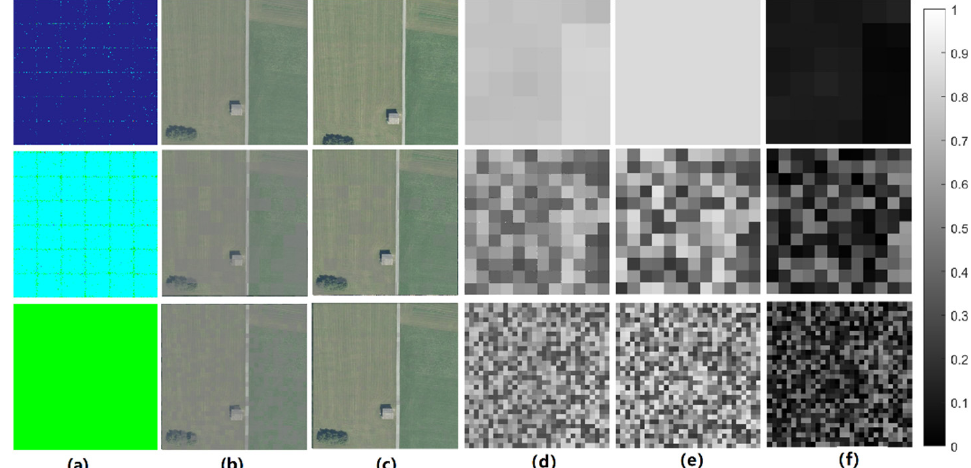
Figure 7. One-step DRL_Dehaze results of different haze scales in farmland area. The first row presents the uniform-haze situation, the second row presents the medium-scale haze situation, and the last row presents the small-scale haze situation. ( a ) Action maps of the hazy aerial images, ( b ) hazy aerial images, ( c ) dehazed clear images of ( b ), ( d ) predicted atmosphere transmission maps, ( e ) ground truth values of the atmosphere transmission maps, and ( f ) differences in the predicted and true atmosphere transmissions. The bar on the right provides reference values for ( d )–( f ). The DRL_Dehaze method can choose the most suitable method for different scales of haze in images.